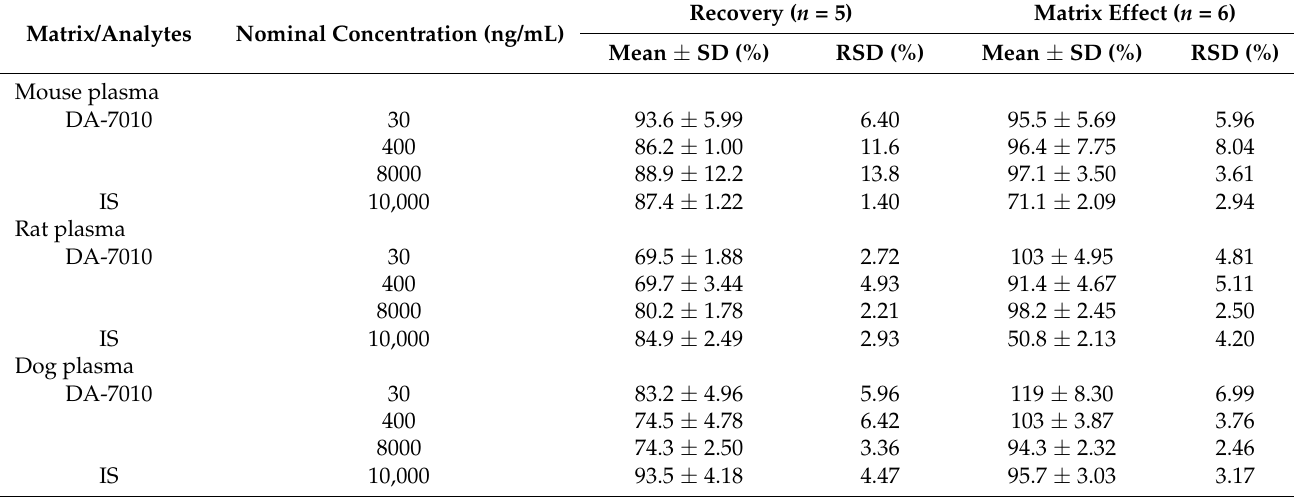
Table 2. Extraction recovery and matrix effect of DA-7010 and the IS in mouse, rat, and dog plasma.